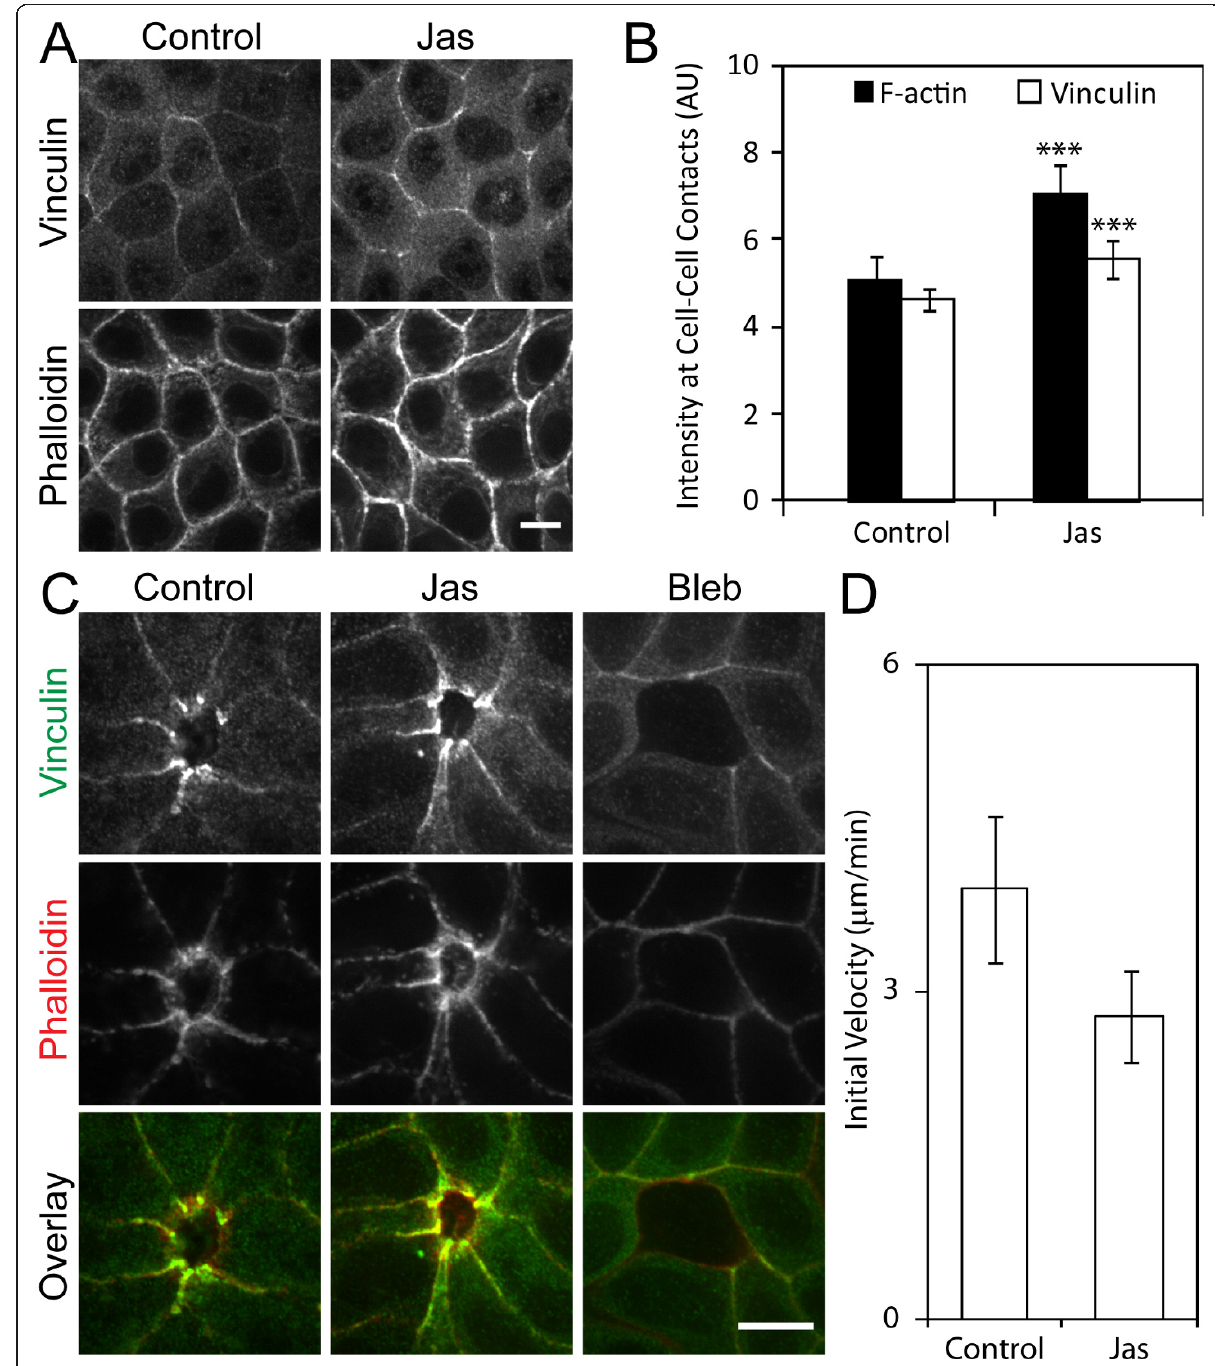
Figure 5 Vinculin recruitment to cell-cell contacts occurs with F-actin stabilization in MDCK cells . (A) Confluent MDCK cell monolayers on collagen-coated coverslips were incubated with media containing 200 nM jasplakinolide (Jas) or media alone (Control), fixed, and immuno- stained for vinculin and F-actin (phalloidin) at cell-cell contacts. The same exposure and laser power were used to acquire and generate the images. Scale bar 10 μ m. (B) Data of immuno-fluorescence intensities and analysis of F-actin and vinculin at cell-cell contacts are presented as mean ± standard deviation and are compared with control (n = 10, ***P < 0.001). (C) Single cell ablations of confluent MDCK wild-type cell monolayers were performed following treatment with media containing 200 nM Jas, 50 μ M blebbistatin (Bleb), or media alone (Control). Vinculin and actin accumulated along the wound edge in Jas-treated and control cells, but was reduced with Bleb treatment. Scale bar 10 μ m. (D) Comparison of the initial velocity of wound-closure between control (n = 8) and Jas-treated (n = 7) cells. Error bars are standard error of the